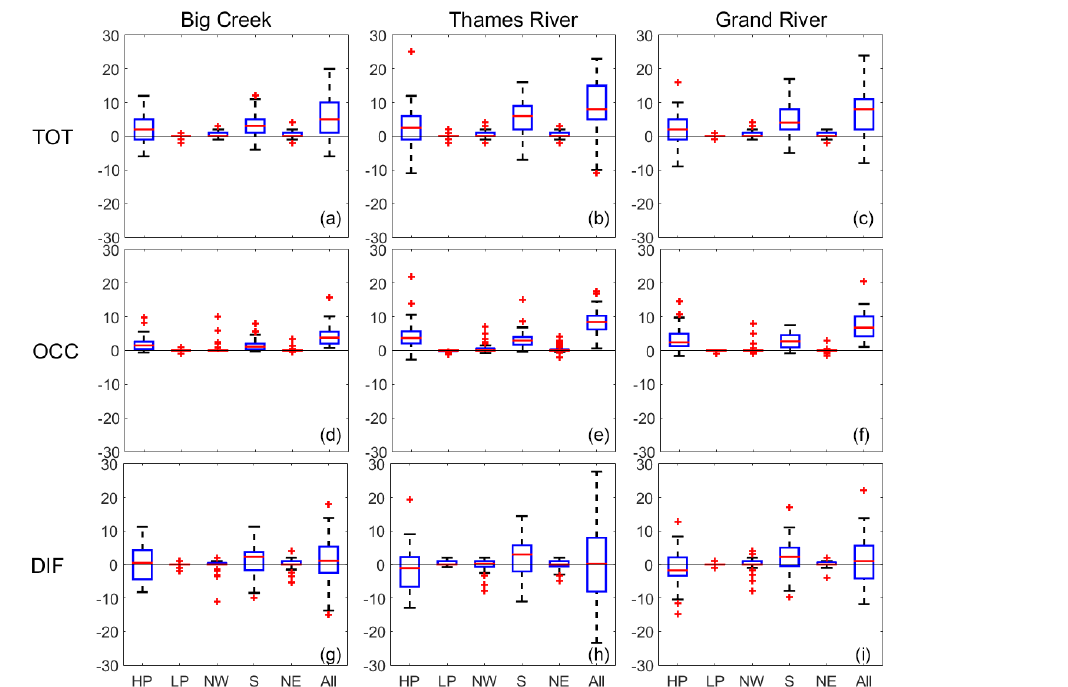
Figure 9. Upper panels: distribution of change in number of high flows between 1961–1990 and 2026–2055 simulated from the 50 members of the ensemble (TOT). Middle panels: distribution of theoretical change in number of high flows using the factor of change in number of heavy rain and warm events between 1961–1990 and 2026–2055 (OCC). Lower panels: TOT minus OCC (DIF). Boxes extend from the 25th to the 75th percentile, with a horizontal red bar showing the median value. The whiskers are lines extending from each end of the box to the 1.5 interquartile range. Plus signs correspond to outliers.